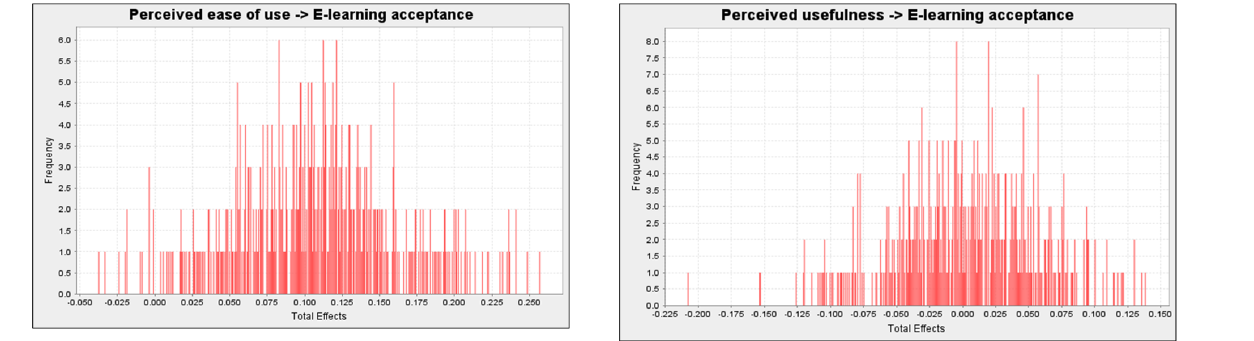
Fig. 5. The impact of perceived ease of use of the students on the behavioral intention to adopt e-learning